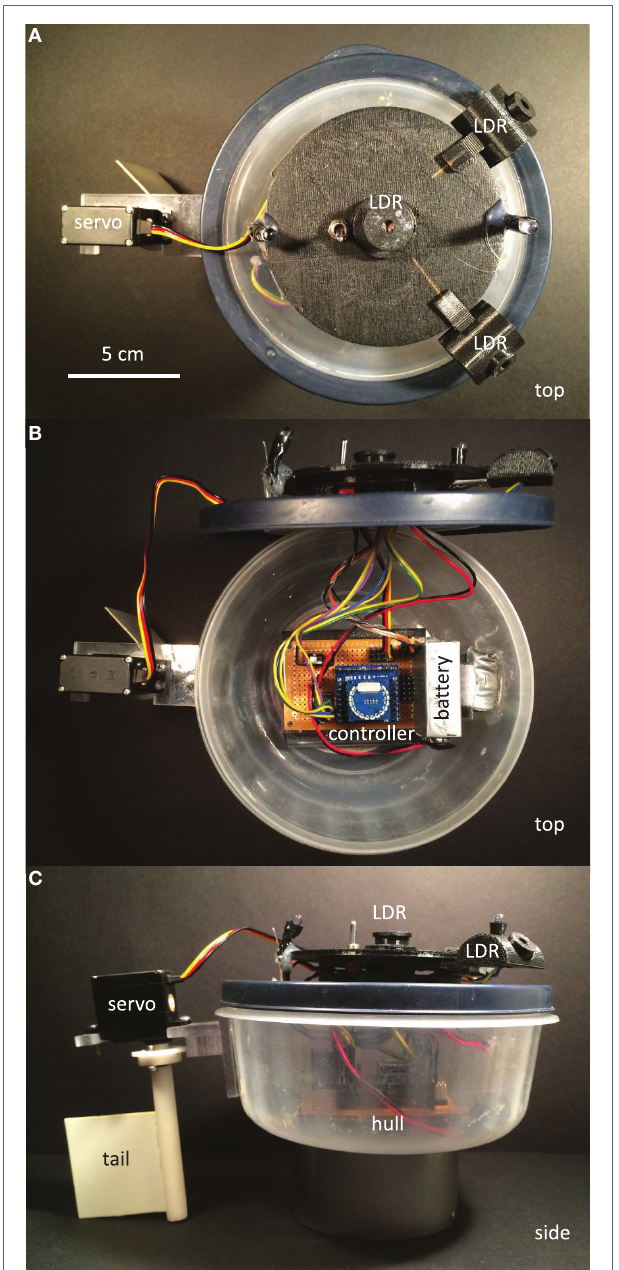
FigUre 2 | Tadro, mechanical design . (a) The two light-dependent resistors (LDRs) on the perimeter, angled at 45° to the horizontal, serve as inputs to the artificial neural network (ANN). The central LDR is the “light mouth,” independent of the net that logs the exposure of the Tadro to light. The servo motor drives the flapping tail. (B) The controller runs the ANN, logs sensory inputs and motor outputs, and logs light intensity from the light mouth. Power is supplied by a 9 V rechargeable lithium battery. (c) The tail is thin, rigid plastic positioned below the bottom of the